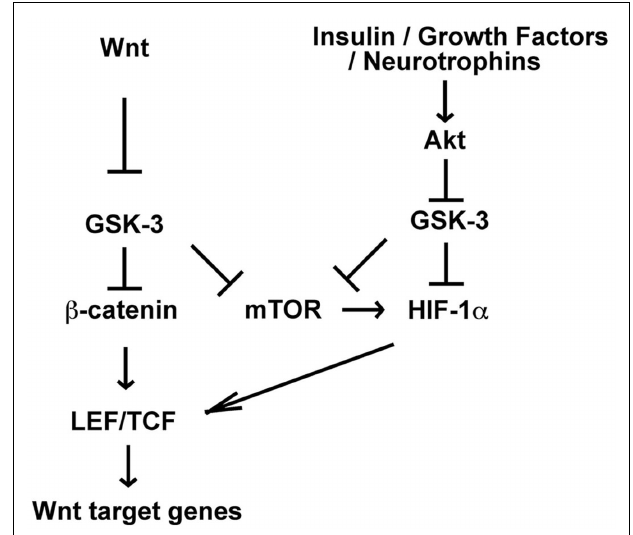
FIGURE 4 | Potential for crosstalk betweenWnt andAkt-dependent signaling pathways through mTOR and HIF-1 α . Wnt and Akt-dependent signaling pathways activate mTOR and mTOR promotes HIF-1 α translation. ThusWnt-induced mTOR activation may enhance HIF-1 α function downstream of Akt. Furthermore HIF-1 α promotesWnt target gene expression by enhancing LEF/TCF transcription in embryonic and neural stem cells, suggesting that HIF-1 α activation downstream of Akt may promoteWnt signaling. Interestingly, GSK-3 has also been shown to contribute to HIF-1 α degradation, and therefore inhibition of GSK-3 by either small molecules or Akt-dependent pathways may also stabilize HIF-1 α